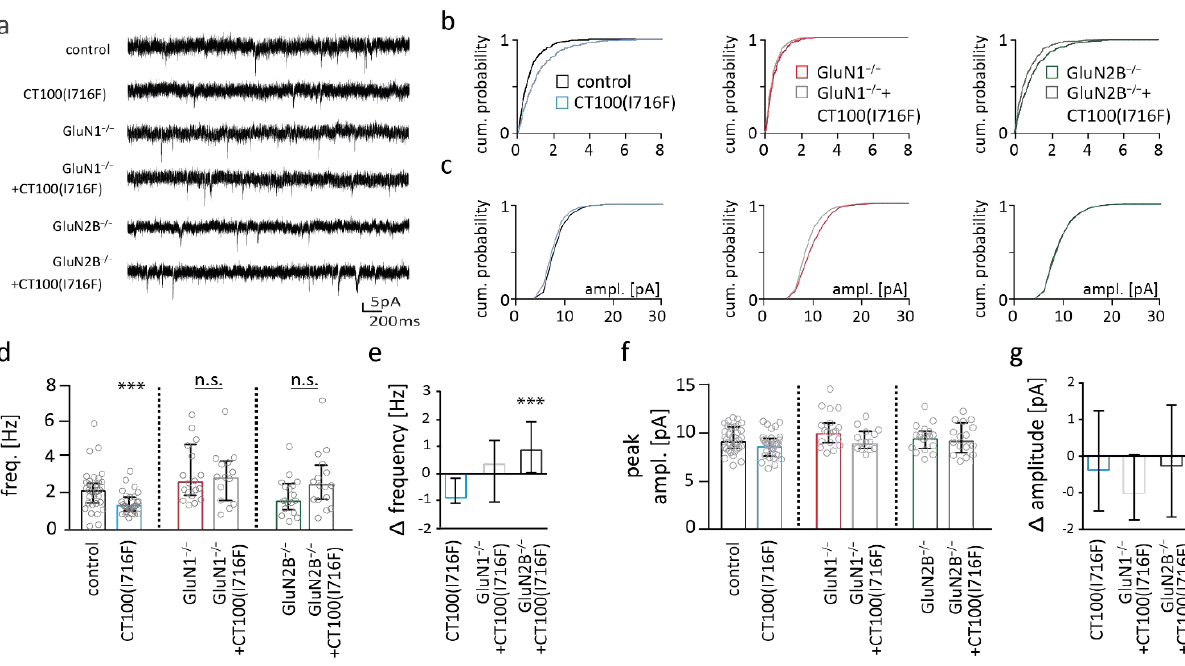
Figure 7. Reduction in miniature excitatory postsynaptic current (mEPSC) frequency is NMDAR-dependent in somatosensory cortex pyramidal cells of amyloid beta ( Aβ )-overexpressing neurons. ( a ) Sample traces of mEPSC recordings. ( b ) Cumulative distribution plots of the median inter-event-intervals (IEI) of mEPSCs from pyramidal cells of the somatosensory cortex. ( c ) Cumulative distribution plots of the median amplitudes (IEI) of mEPSCs. ( d ) Bar graphs of mEPSC frequencies of control ( n = 35) and CT100(I716F)-overexpressing ( n = 31) neurons without (left) and with deletion of GluN1 (middle) ( n = 19 GluN1 −/− vs. n = 14 CT100(I716F)/GluN1 −/− ) or GluN2B (right) ( n = 18 GluN2B −/− vs. n = 16 CT100(I716F)/GluN2B −/− ). ( e ) Bar graph showing the change in mEPSC frequency in pyramidal cells from CT100(I716F)-overexpressing neurons when compared to the respective control neurons (control, GluN1 −/− , GluN2B −/− ), quantified from data in ( d ). ( f ) Bar graphs of peak amplitude of mEPSCs from control and CT100(I716F)-overexpressing neurons without (left) and with deletion of GluN1 (middle) or GluN2B (right). ( g ) Bar graph showing the change in mEPSC amplitude in pyramidal cells from CT100(I716F)-overexpressing neurons when compared to the respective control neurons (control, GluN1 −/− , GluN2B −/− ), quantified from data in ( f ). Data in bar graphs are shown as median ± interquartile range. Empty grey circles depict single data points. Mann – Whitney test/Kruskal – Wallis test: *** p < 0.001.